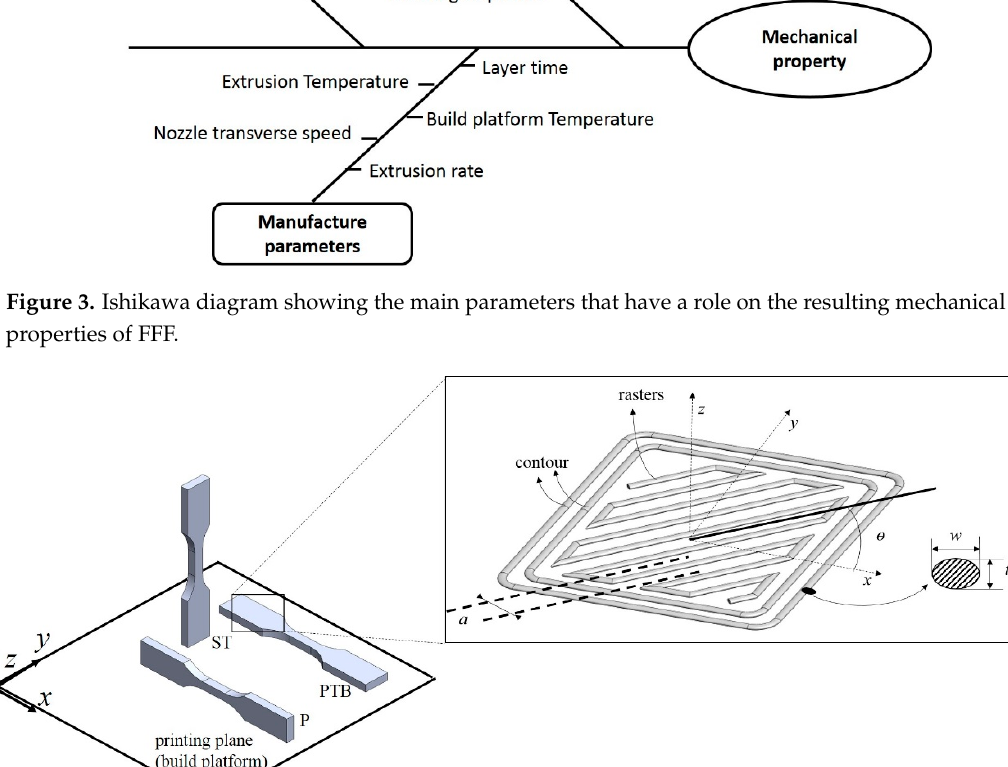
Figure 3. Ishikawa diagram showing the main parameters that have a role on the resulting mechanical properties of FFF.